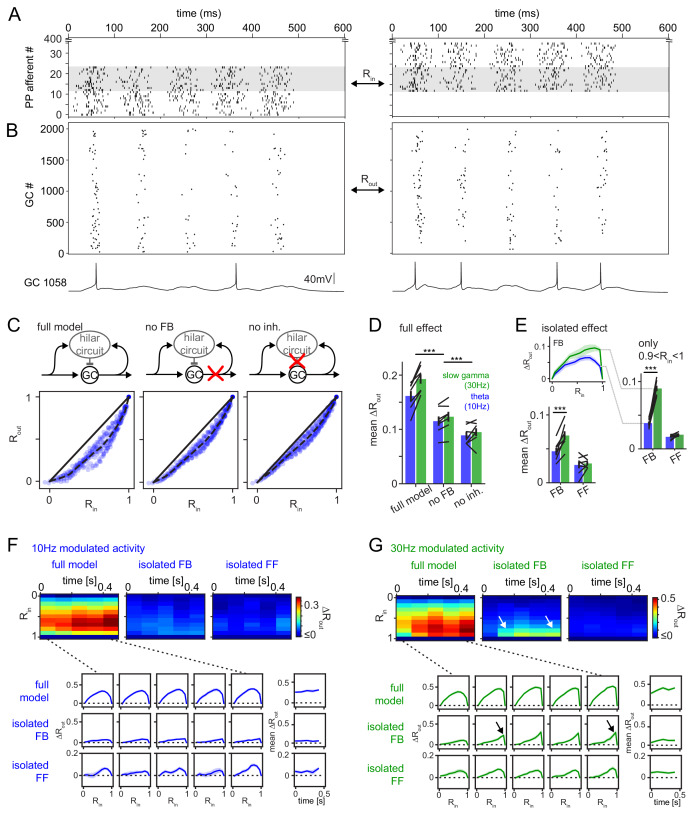
Frequency dependent pattern separation of temporally structured inputs.The quantitative DG model was challenged with theta (10 Hz) or slow gamma (30 Hz) modulated input patterns with defined overlap to probe its pattern separation ability. (A) Pair of theta modulated perforant path input patterns in which 50% of afferents overlap (grey area). (B) Resulting pair of GC output patterns of the full tuned network. Bottom: Representative individual GC underlying the observed patterns. (C) Comparison of 325 input pattern pairs and their resulting output pattern pairs. Each pair is characterized by its rate vector correlation for inputs (Rin) and outputs (Rout), where rates are measured over the full 600 ms time window. Dashed black lines represent the bin-wise mean Rout (in Rin bins of 0.1). Left: full tuned model, middle: model without mossy fiber inputs to interneurons, right: model without inhibitory synapses. (D) Full pattern separation effects (mean ΔRout) of all three conditions for both frequency domains quantified as the area enclosed by the dashed and unity lines in (C). Black lines represent individual network seeds. Two-way RM ANOVA indicated significance of condition, frequency and interaction, * indicate significance in Sidak’s posttests between individual conditions. (E) Isolated effects of feedback and feedforward motifs obtained by pairwise subtraction of Rout between conditions for each individual comparison. The inset shows the resulting ΔRout for each Rin bin. The area under the curve quantifies the mean ΔRout as in (D). Two-way RM ANOVA indicated significance of condition, frequency and interaction. *** indicate p<0.001 in Sidak’s posttest. (F). 100 ms time-resolved pattern separation effects of the full model, isolated FB or FF inhibition for theta modulated input (10 Hz). All analyses were performed as above but with rate vector correlations computed for 100 ms time windows. The bottom insets show ΔRout as a function of input similarity for each time window. The bottom right insets show the evolution of the mean ΔRout over time. (G) Same as (F) but for slow gamma (30 Hz) modulated inputs. Arrow indicate the region of selectively increased pattern separation. Data in D-G represent mean ± SEM of n = 7 random network seeds.